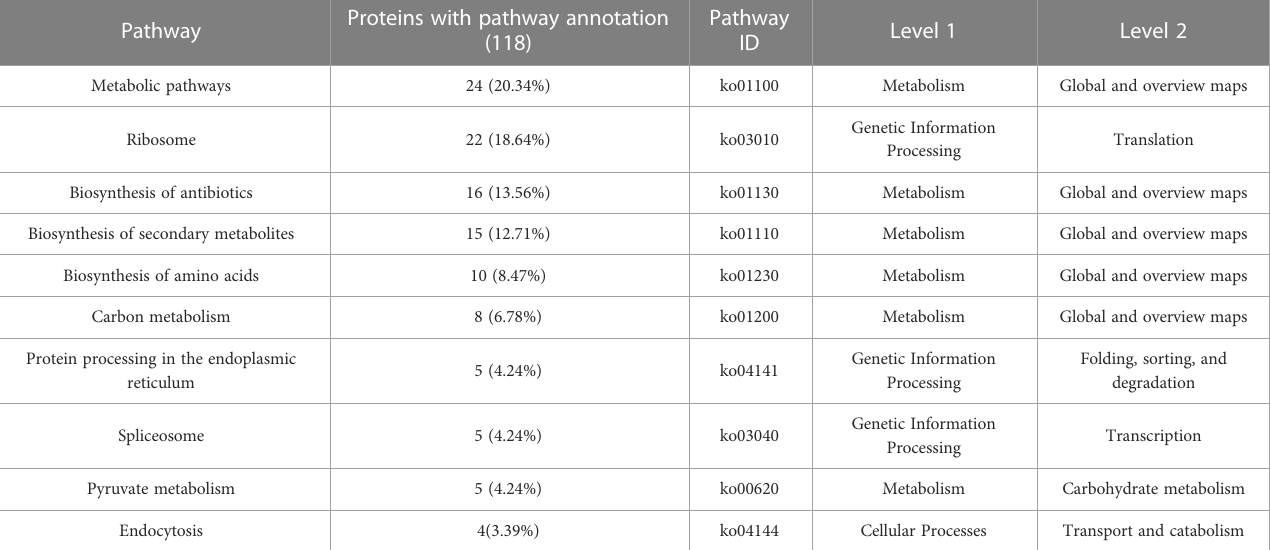
TABLE 4 Top 10 pathway from KEGG pathways functional enrichment analysis. Pathway